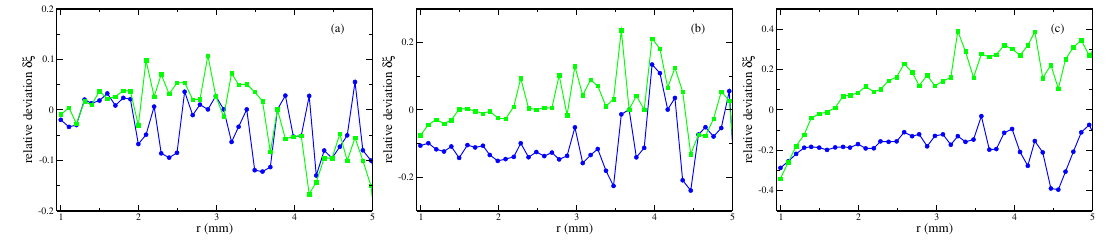
Figure 5. Relative deviation δξ , see Equation (8), of the numerically calculated menisci of the magnetic fluid EMG 909 using a linear law of magnetisation with χ = 0.61 ( • ) and χ = 0.8 ( (cid:4) ). ( a ) H = 3.35 kA/m, ( b ) H = 7.54 kA/m and ( c ) H = 11.73 kA/m at R = 0.95 mm. The lines are guides for the eye. Note the different scales at the axes of ordinates.